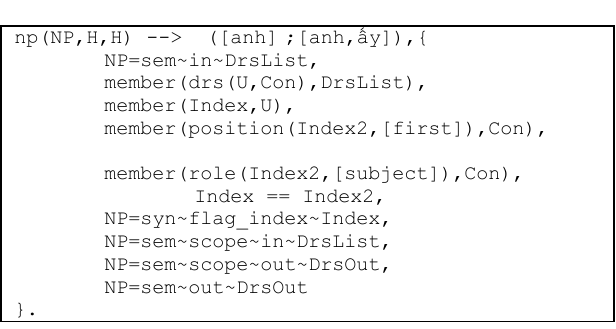
Figure 16. Implement Algorithm 3 based on framework GULP